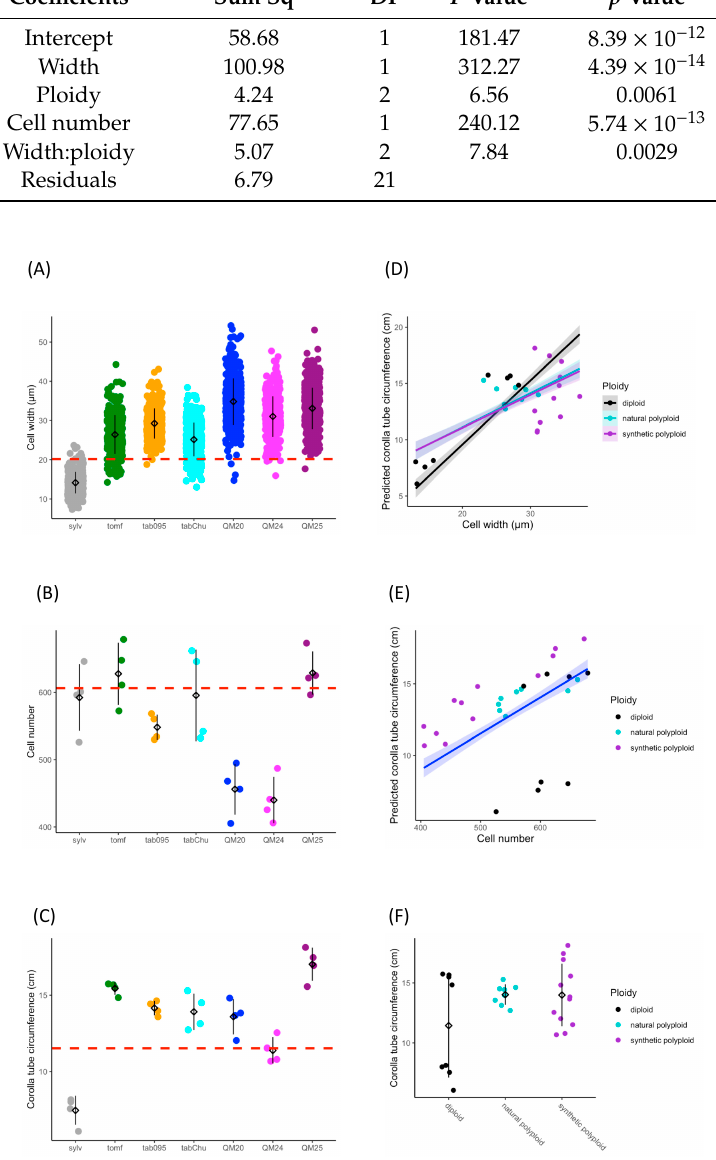
Figure 2. Strip plots for ( A ) cell width from 100 cells, ( B ) cell number, and ( C ) corolla tube circumference for all accessions, including mean and standard deviation for each accession: red dotted lines represent the progenitor average, which is the expected intermediate phenotype. Predicted corolla tube circumference based on the linear model for ( D ) cell width and ( E ) cell number: points represent actual flower data. Corolla tube circumference based on ( F ) ploidy including mean and standard deviation for each ploidy: points represent actual flower data. Sylv = N. sylvestris , tomf = N. tomentosiformis